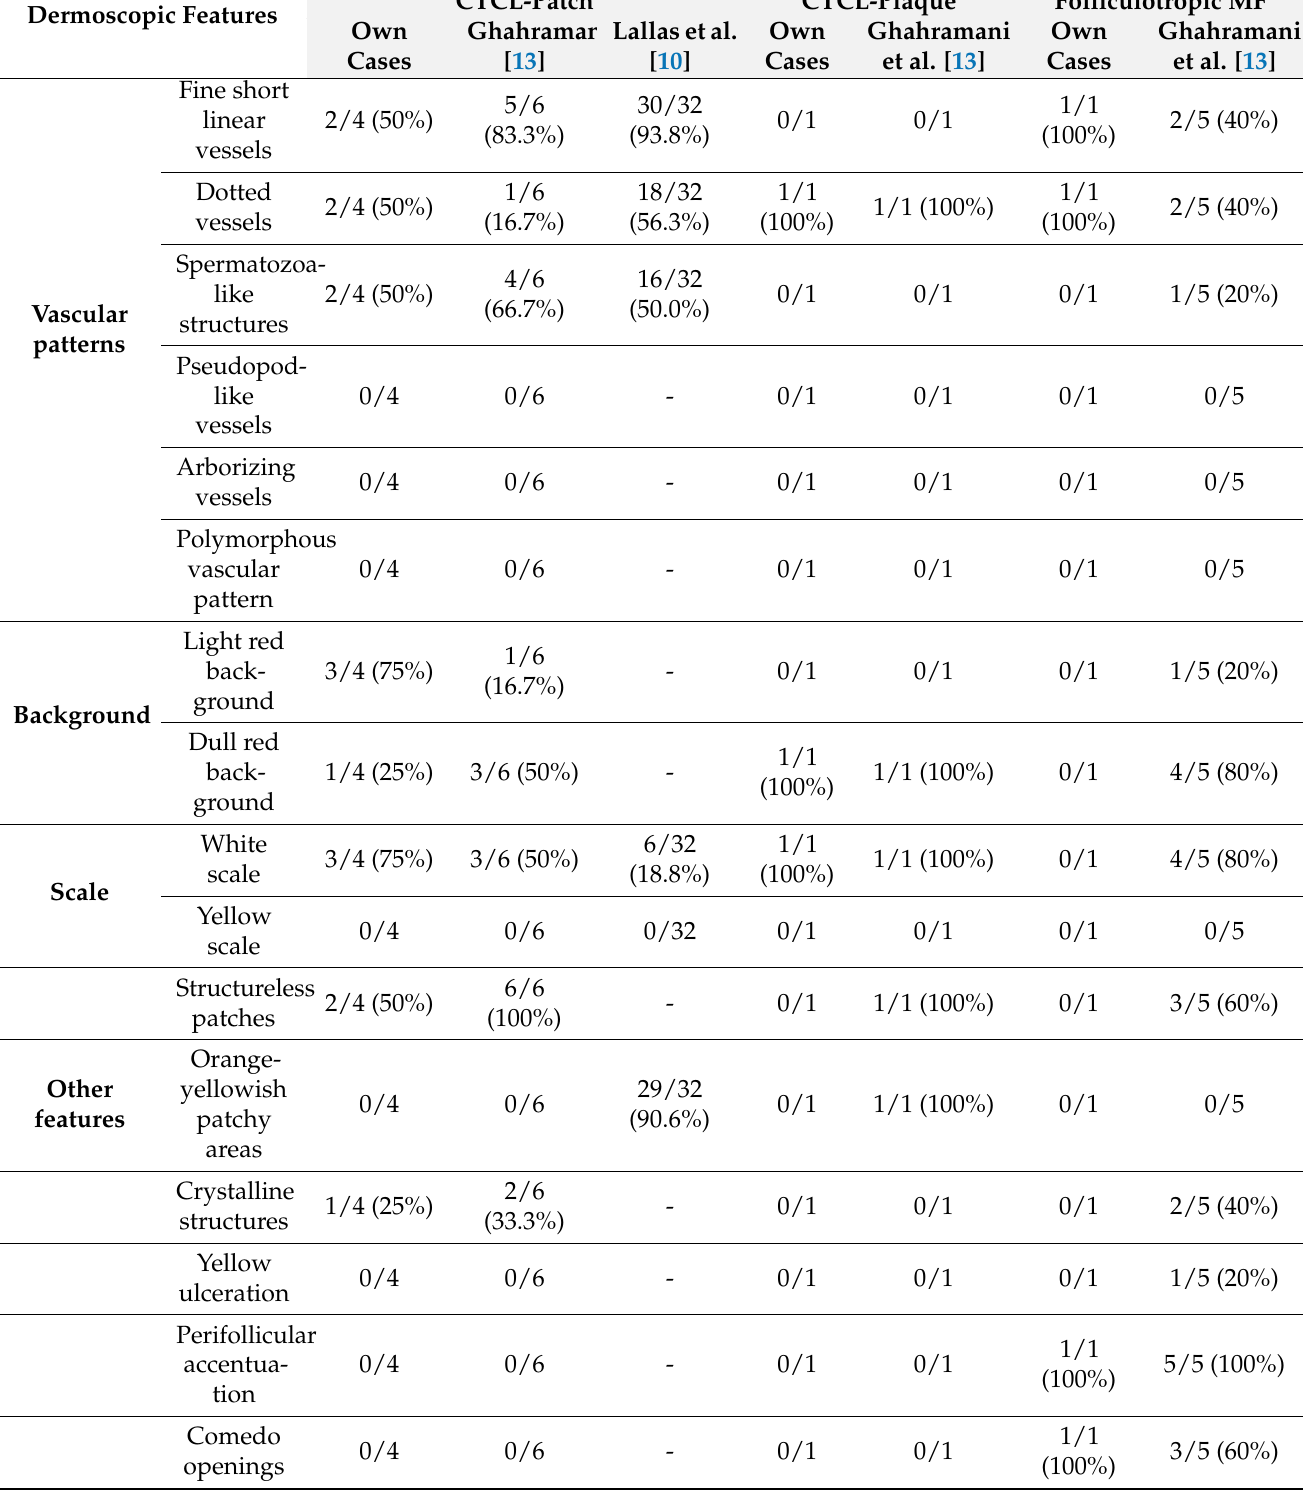
Table 1. Dermoscopy features of cutaneous T-cell lymphomas